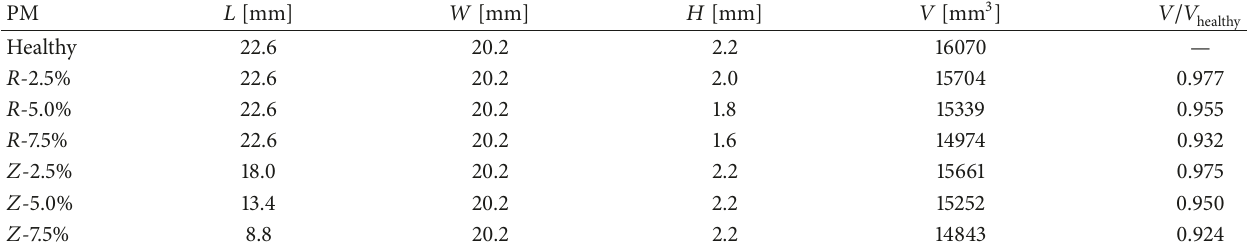
Figure 3: PMs for axial demagnetization. Table 1: Dimension of PMs.